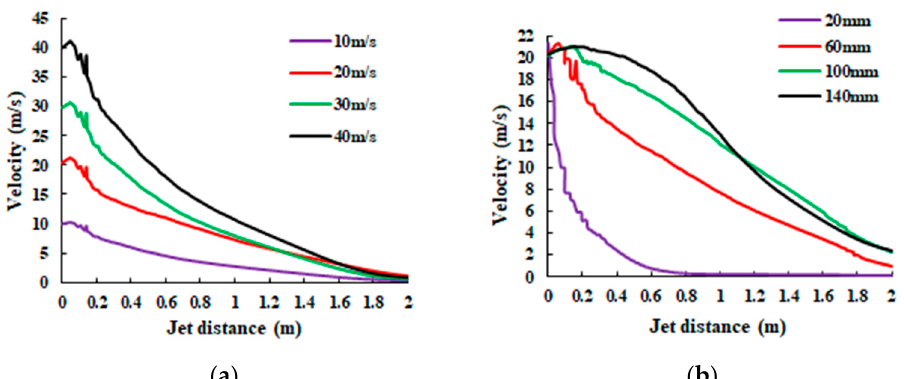
Figure 4. Velocity change on the centerline of the flow field: (a) different inlet velocity; (b) different leak hole size.